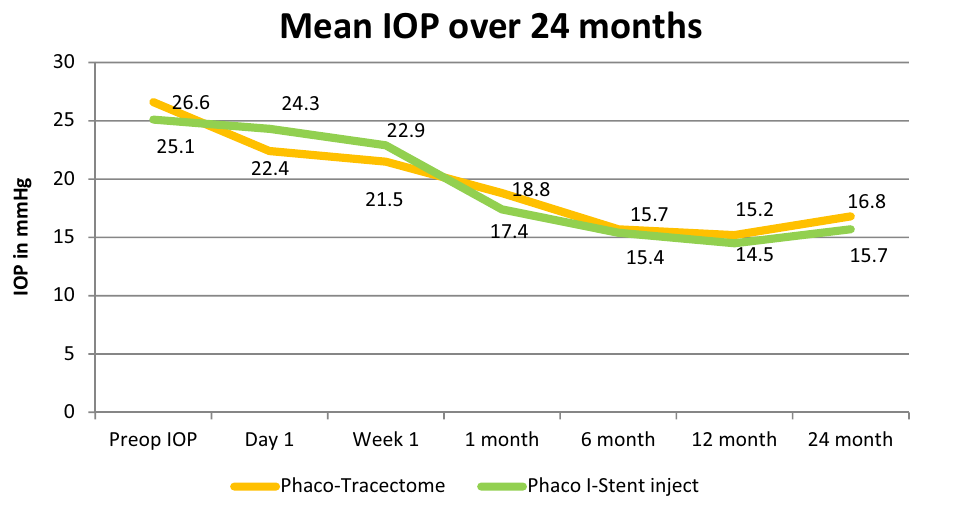
Figure 1. Mean IOP over 24 months (2 years).